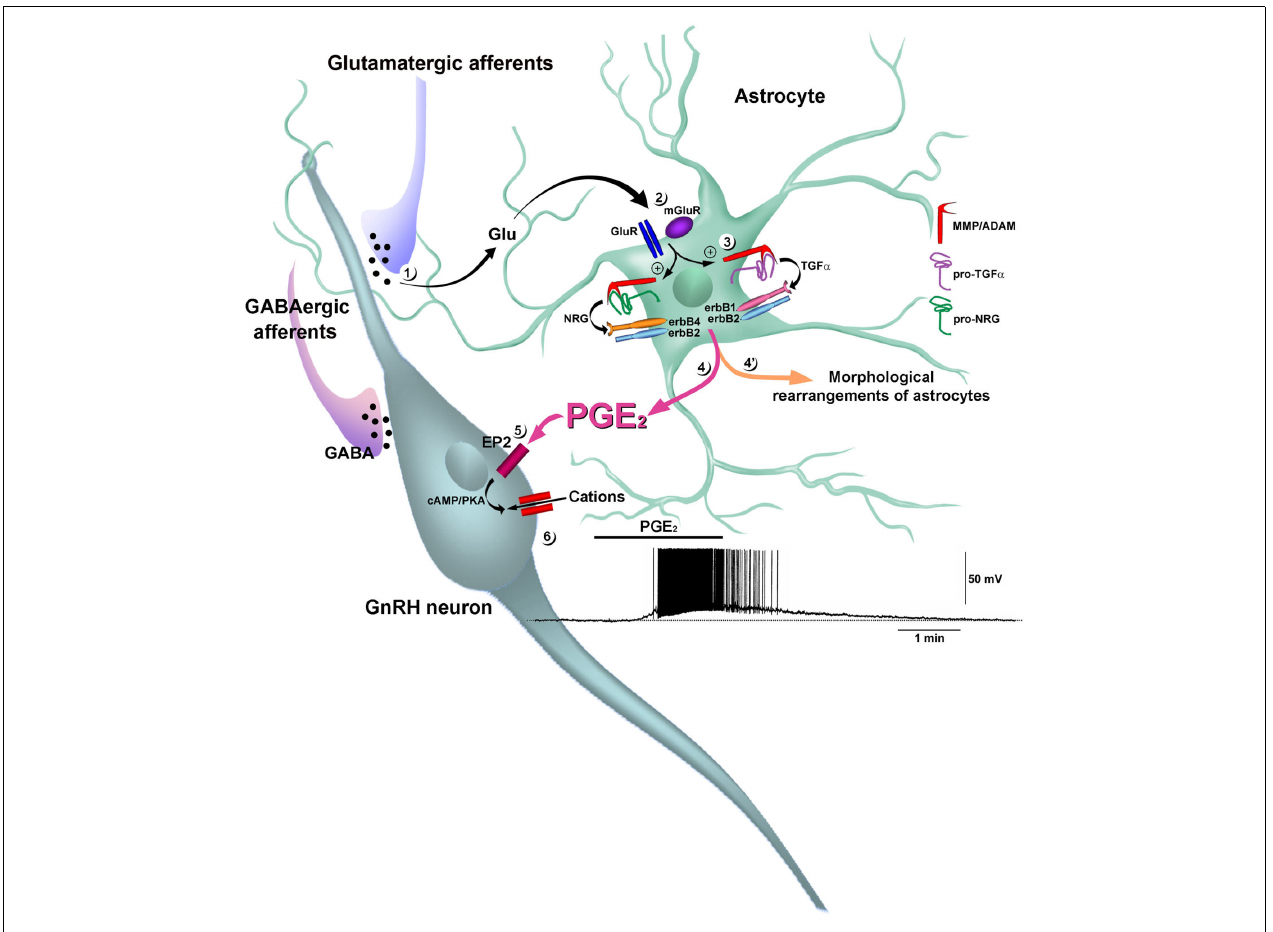
the cell membrane, where multiprotein complexes form, as demonstrated by the direct physical association of glutamatergic and erbB receptors (not shown).The activation of erbB receptors in hypothalamic astrocytes promotes profound morphological changes, including the retraction of cytoplasm, stellation of cells and the elongation of processes (see Figure 4G–I ) (4 (cid:2) ).The activation of erbB receptors also promotes the release of PGE 2 (Ma et al., 1997, 1999; Dziedzic et al., 2003) (4), which stimulates a cAMP/protein kinase A (PKA) pathway in GnRH neurons through the mobilization of EP2 receptors (EP2; Clasadonte et al., 2011) (5). Activation of this signaling pathway induces a reversible membrane depolarization of GnRH neurons leading to the initiation of spike firing via a postsynaptic effect involving the activation of a non-selective cation current (Clasadonte et al., 2011)